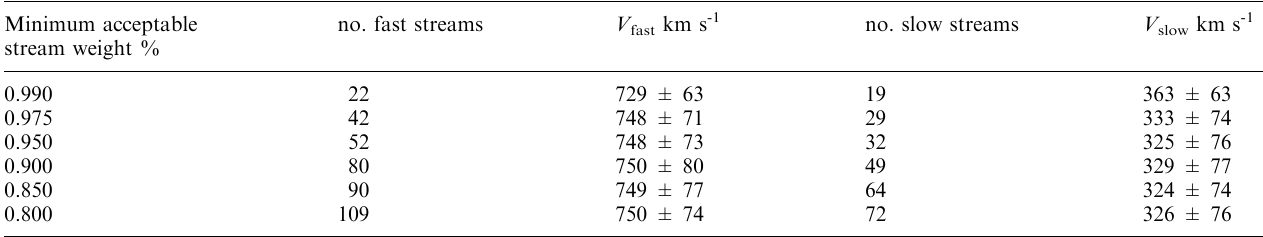
no. fast streams